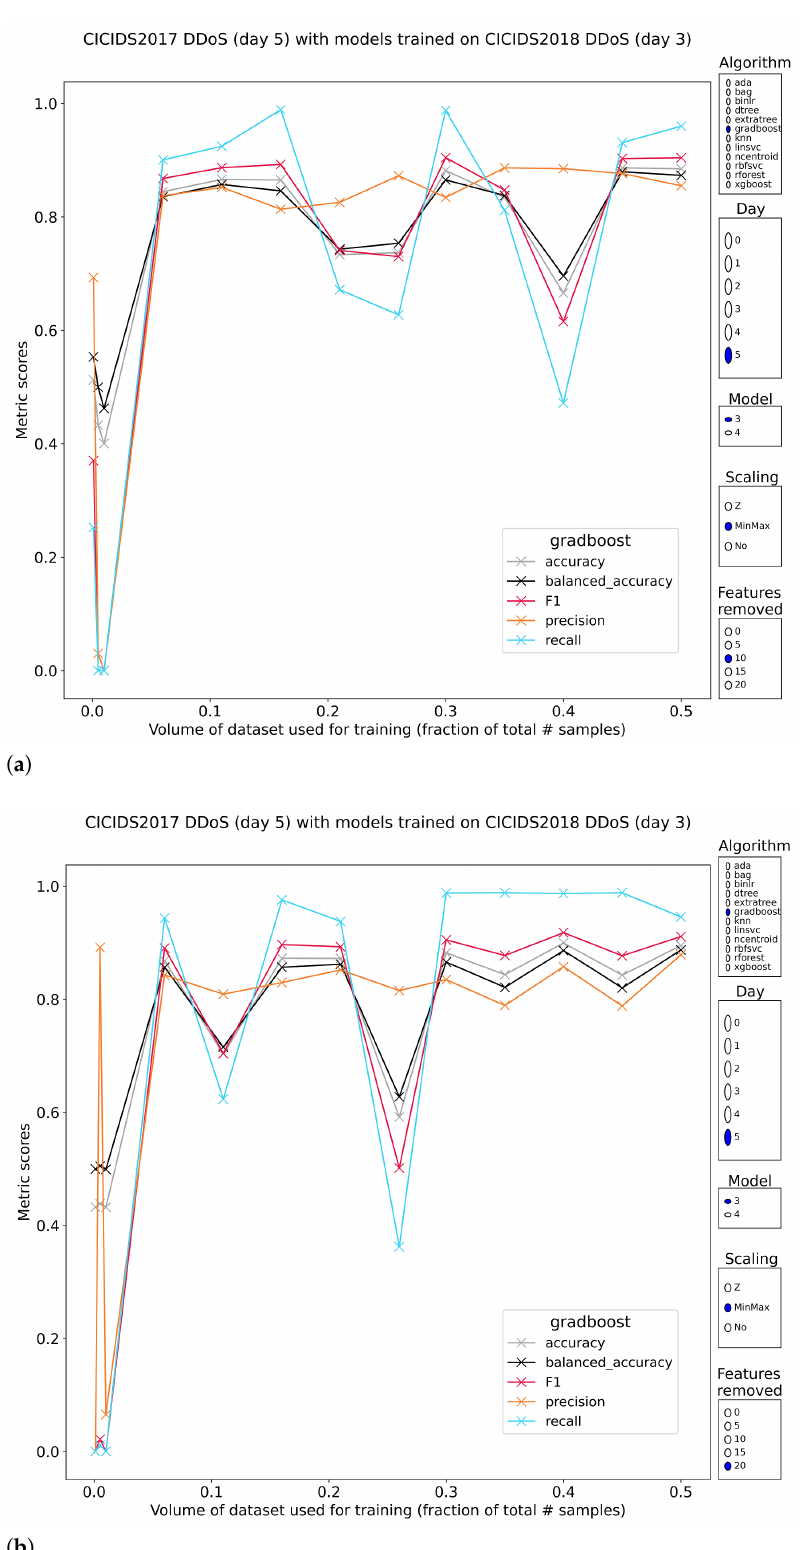
Figure 9. Generalized performance on the DDoS attack class by tree-based models can happen with modest losses in performance, but the unpredictability with regard to stability is a major downside ( a , b